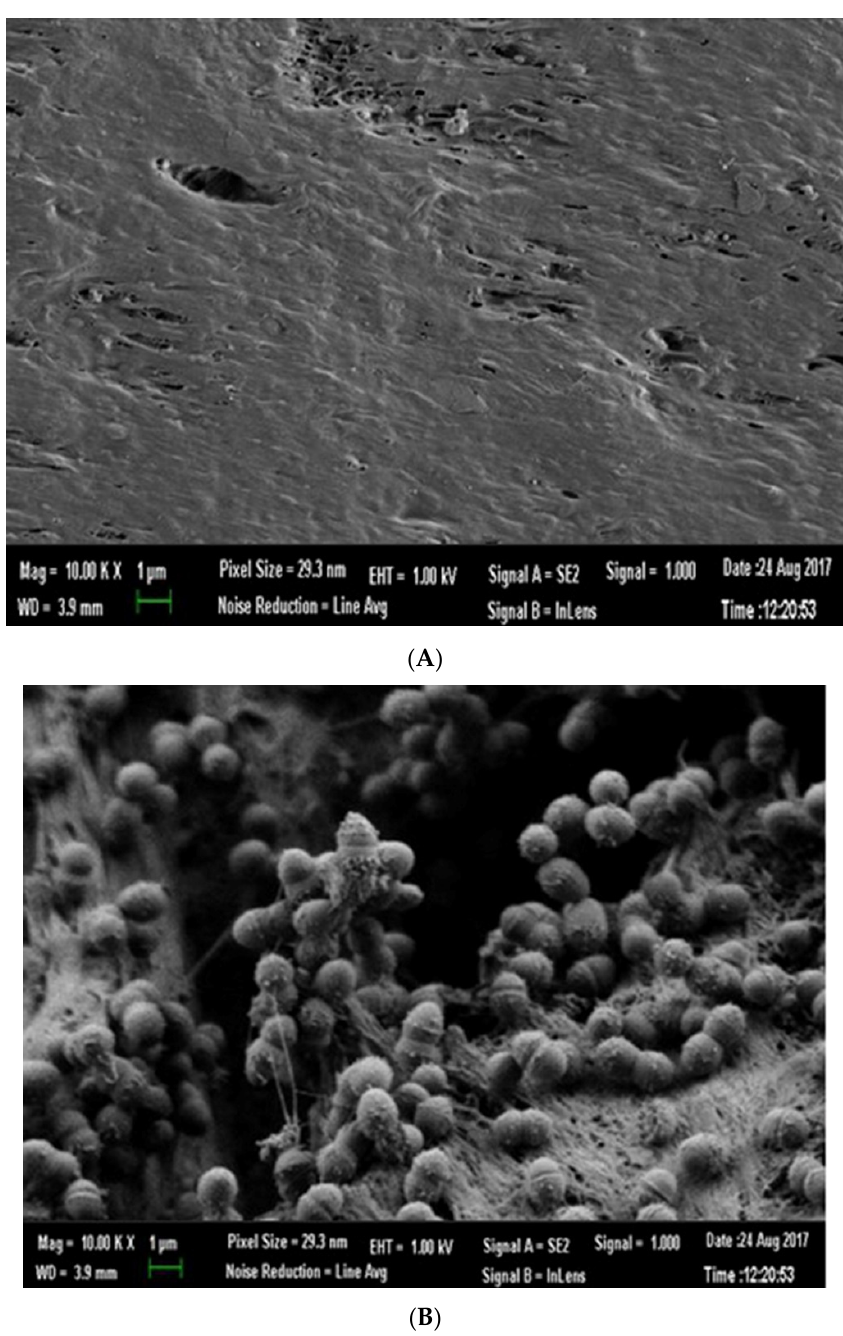
Figure 2. ( A ) Scanning electron microscope image of biofilm on infected GP. ( B ) Scanning electron microscope image of sterilized GP.